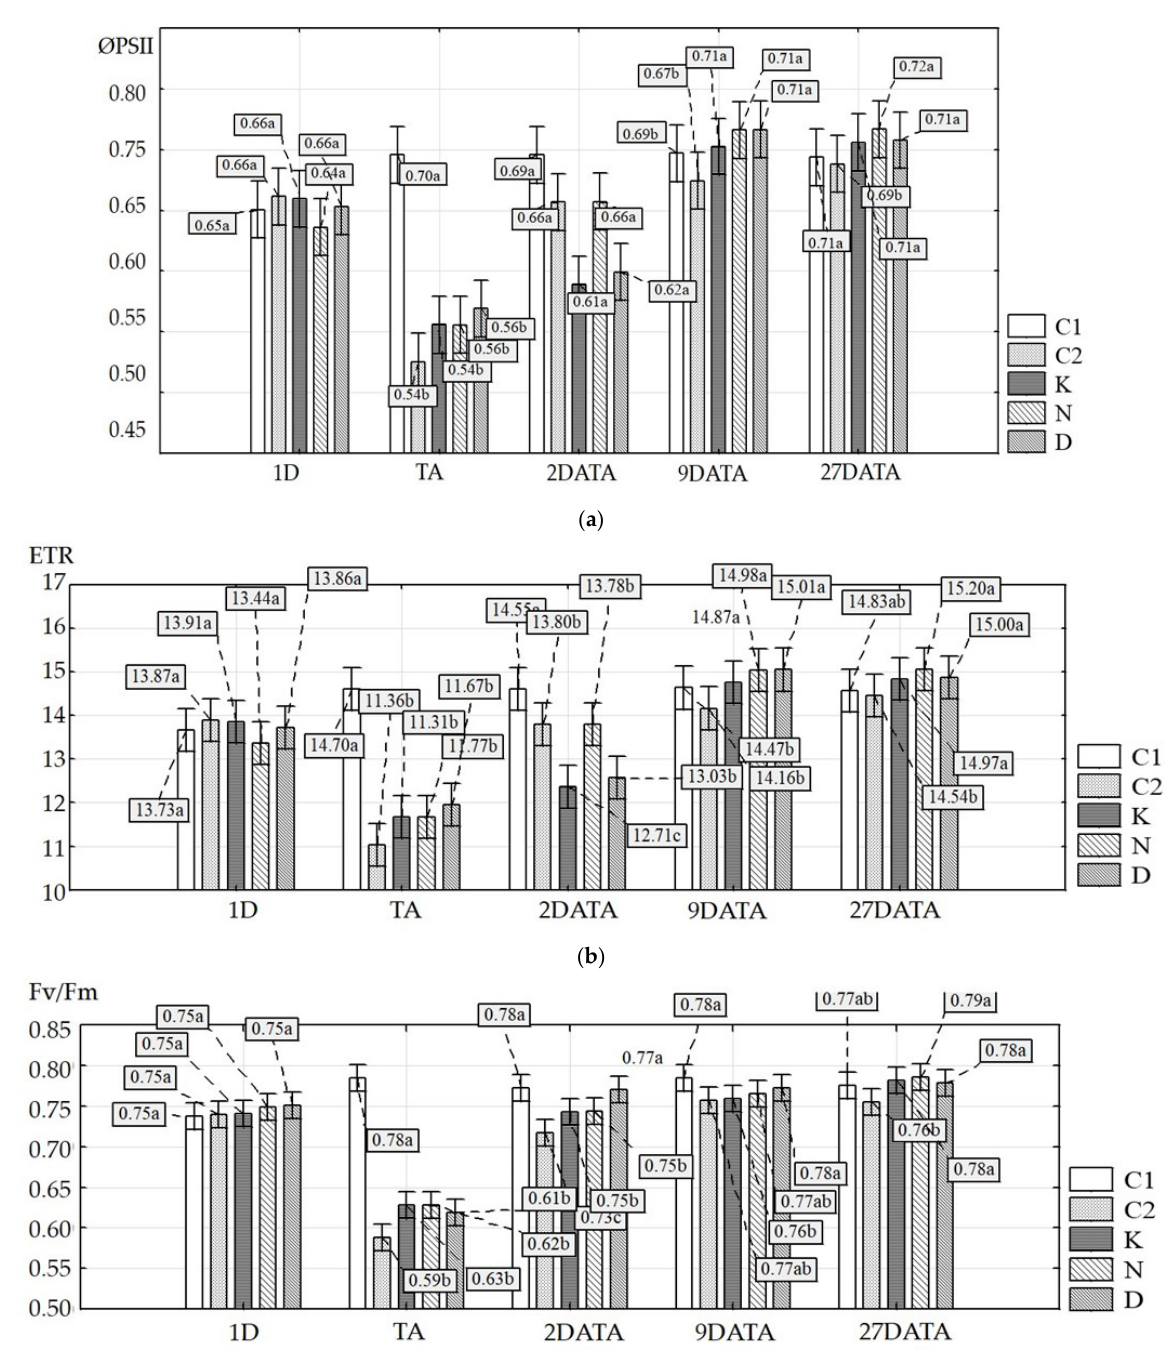
Figure 1. Effects of phytostimulators and time of measurements on chlorophyll fluorescence parameters of maize leaves. ( a ) Effective quantum yield of photosystem II in the light, ( b ) electron transport rate, ( c ) maximum photosynthetic efficiency of PSII, different treatments and the values followed by a different letter show statistically significant differences within treatments at p < 0.05. Vertical ba rs mean ± SE, control treatment under normal growth conditions without cold stress (C1), second control treatment under stress growth conditions with cold (C2) , Kelpak ® (K) , Nano